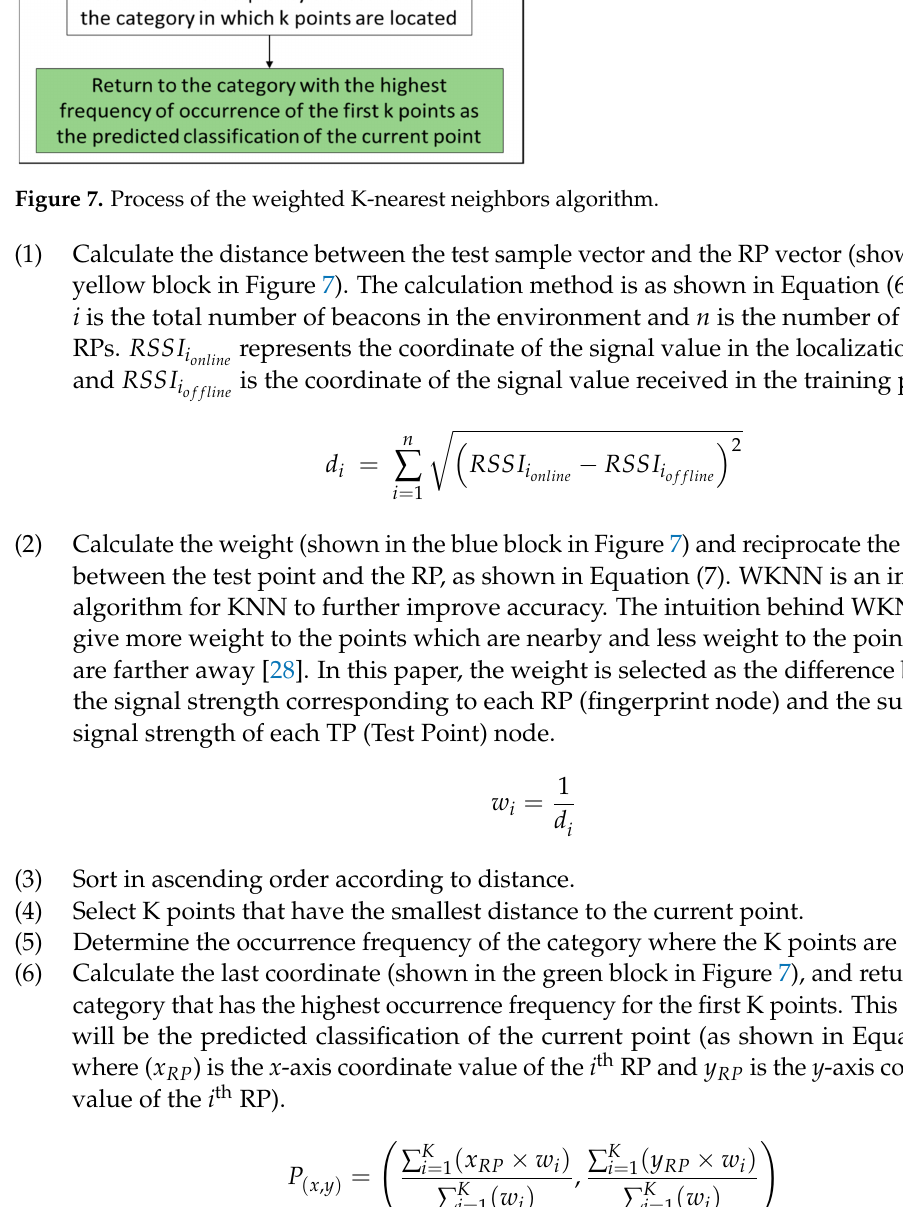
Determine the occurrence frequency of the category where the K points are located. Calculate the last coordinate (shown in the green block in Figure 7), and return to the category that has the highest occurrence frequency for the first K points. This category will be the predicted classification of the current point (as shown in Equation (8), where ( x RP ) is the x -axis coordinate value of the i th RP and y RP is the y -axis coordinate value of the i th